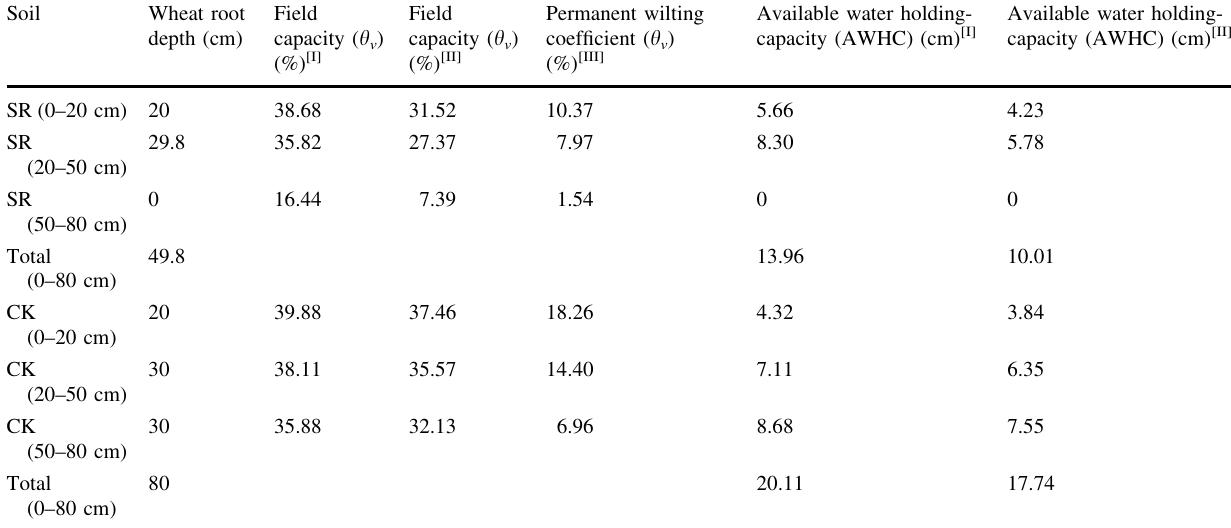
Available water holding- capacity (AWHC) (cm) [I]